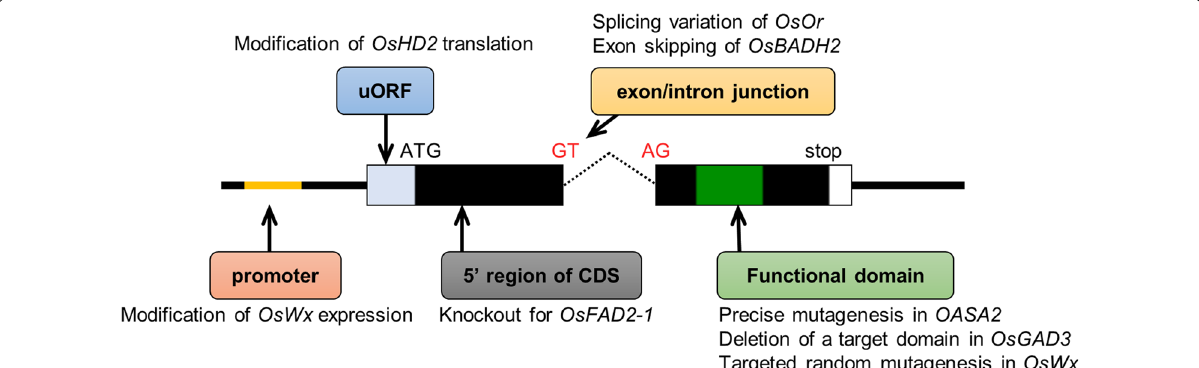
Fig. 2 Target regions of gene modification by genome editing technology. Regions targeted by genome editing and examples of gene modification shown in this review are summarized. The yellow line indicates the cis-regulatory element in the promoter region of a target gene. Light blue and white boxes indicate 5 ′ and 3 ′ untranslated regions of a target gene, respectively. Black and green boxes indicate coding regions of a target gene and a region corresponding to the functional domain of a translated protein, respectively. Solid and dotted lines indicate the target gene locus and the intron of the target gene,